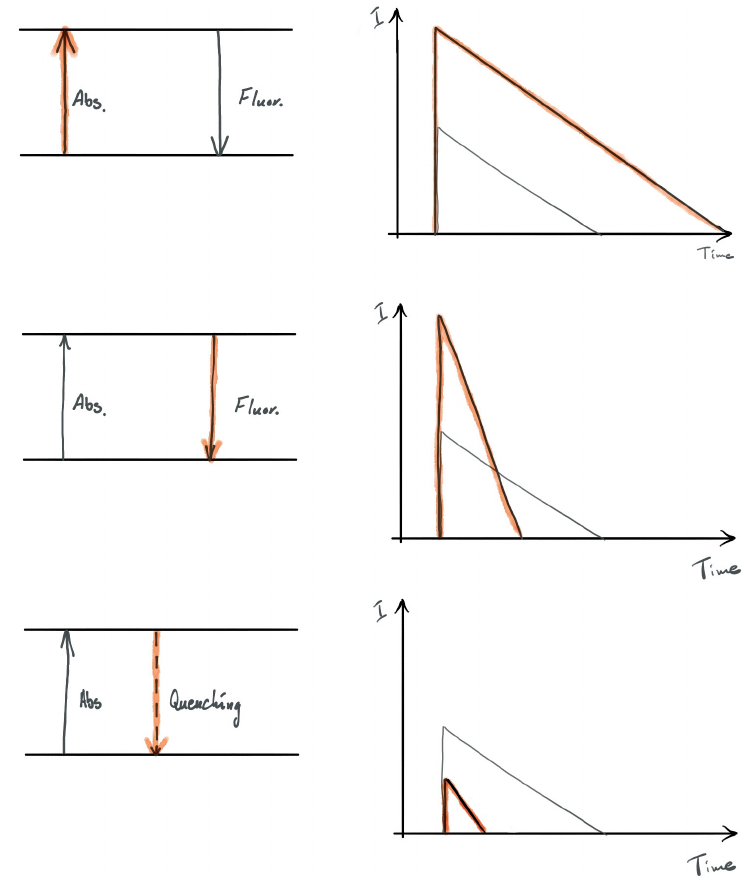
Figure 2. Spectroscopic changes of the optical response of a molecule (nanocrystal, fluorescent protein) coupled to metallic nanoparticle. The rows from top correspond to enhancement of the excitation rate, enhancement of radiative rate, and influence of the non-radiative energy transfer, respectively. Abs and Fluor correspond to absorption and fluorescence, respectively.